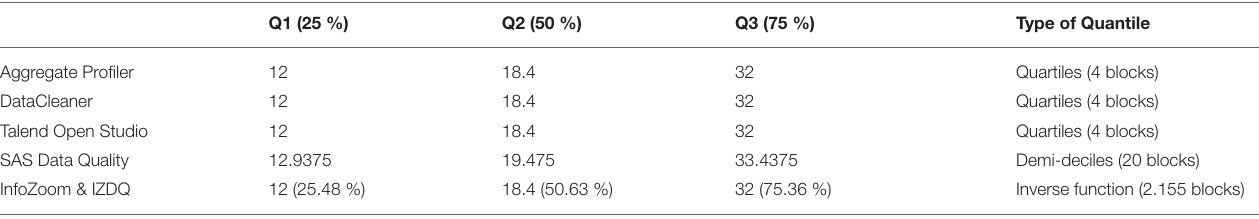
TABLE 6 | Data profiling—test case